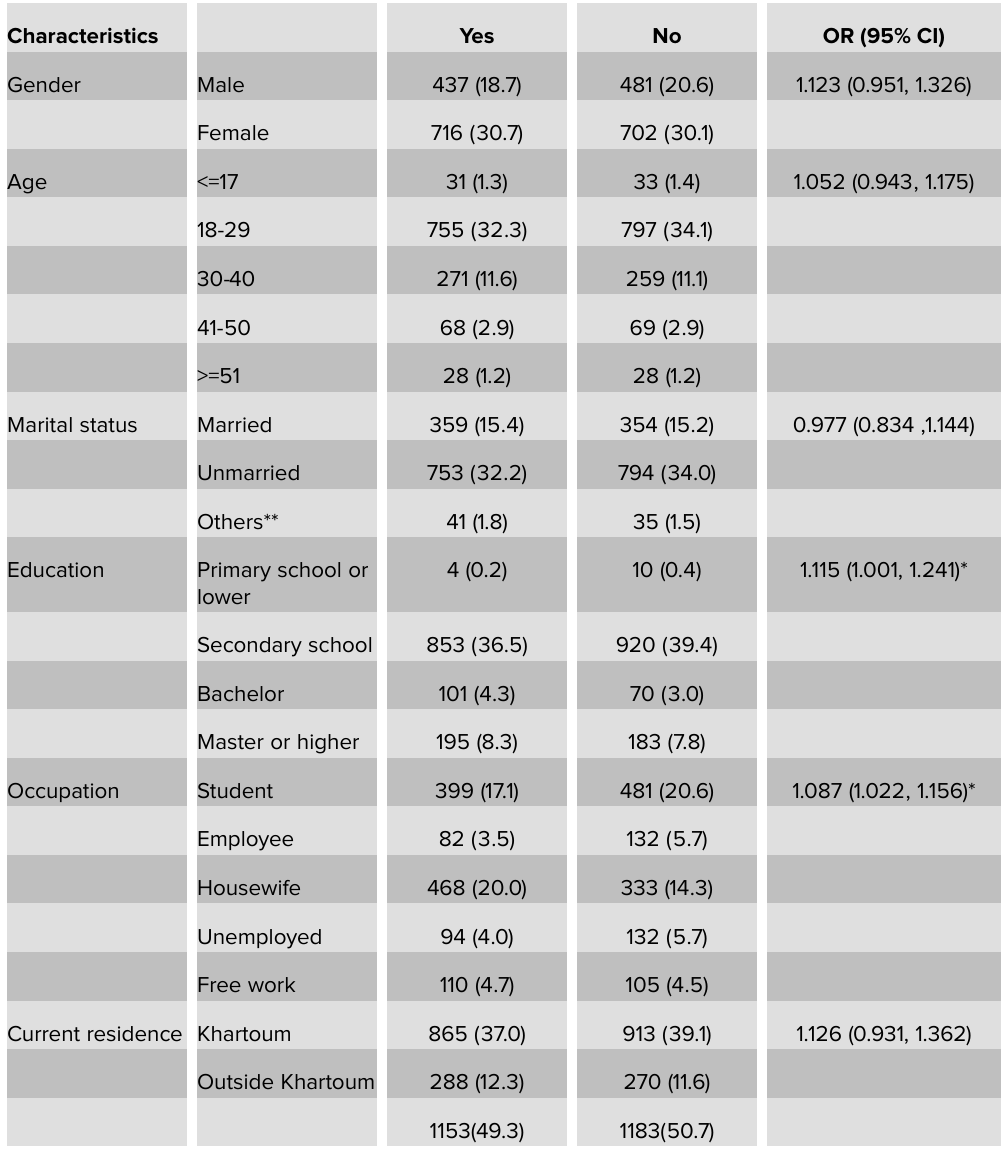
TABLE 7: Practices towards COVID-19 by demographic variables, (In the last few days, have you worn a mask when leaving home?)